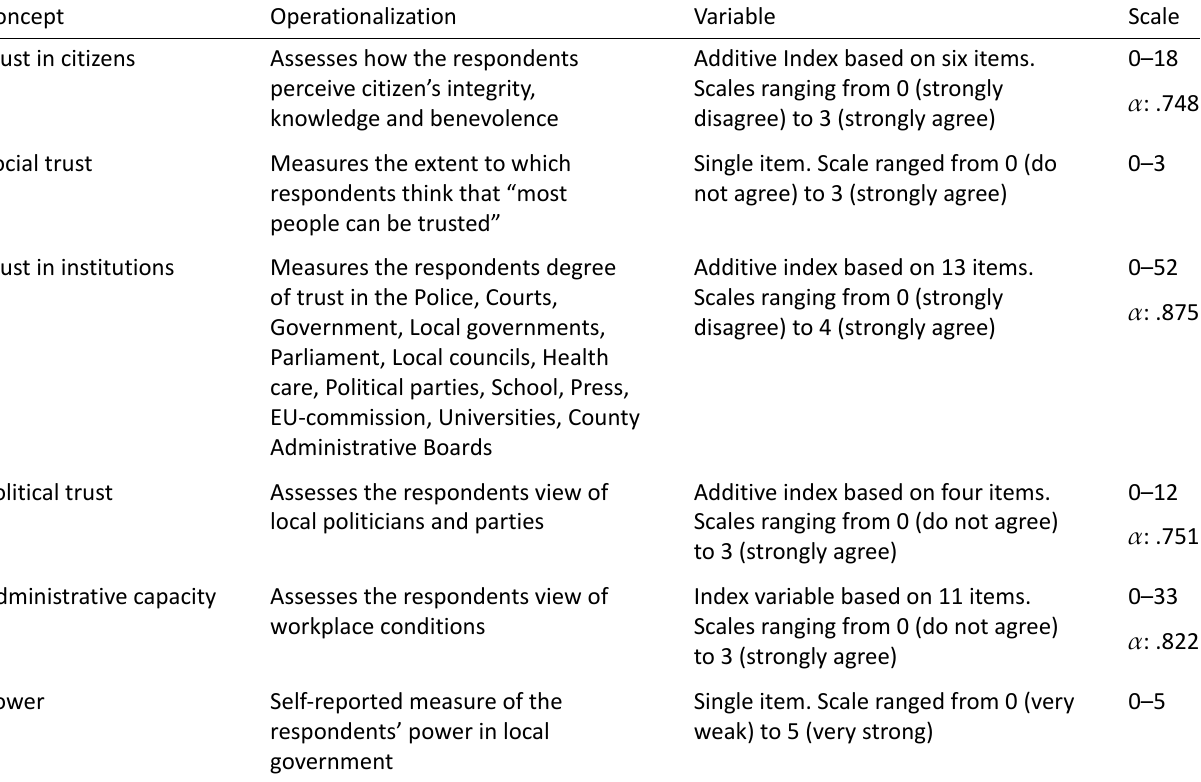
Table 1. Operationalization and measurements.